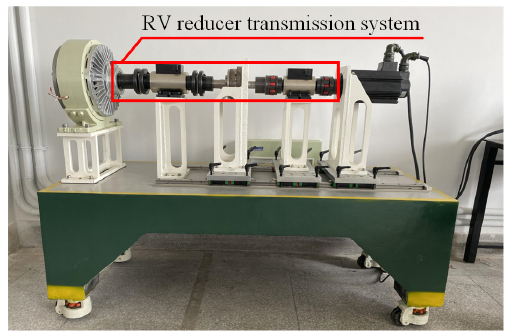
Figure 2. Simplified model of transmission system: (1) servo mo- tor, (2) plum blossom coupling, (3) RV reducer, (4) raster encoder, (5) torque sensor, (6) diaphragm coupling, and (7) magnetic powder